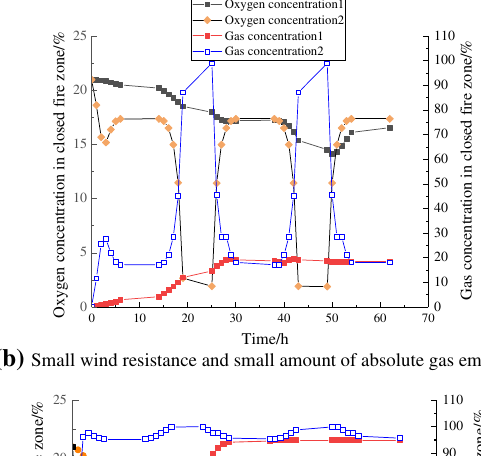
(b) Small wind resistance and small amount of absolute gas emission